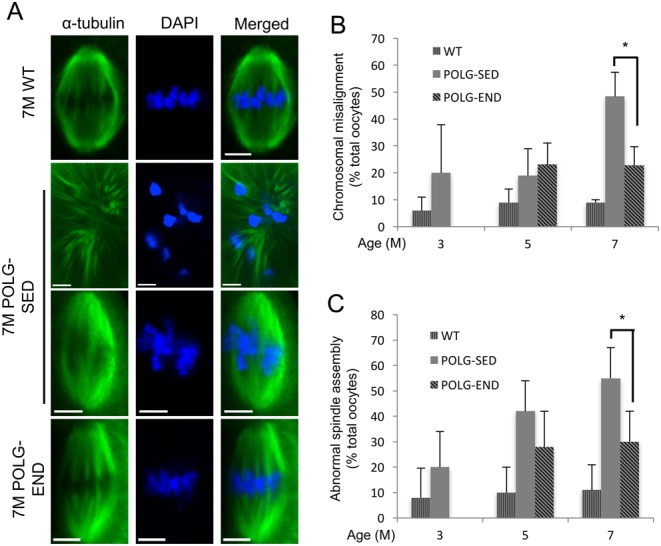
Exercise improves meiotic spindles and chromosome alignment in POLG mice at 7 months of age. (A) Representative laser scanning confocal micrographs of meiotic spindles in MII oocytes from 7-month-old (7 M) WT, POLG-sedentary (POLG-SED) and POLG endurance-exercised (POLG-END) mice; α-tubulin labeling of spindle (green) and DNA labeled with DAPI (blue). Scale bars = 5 μm. (B and C) Occurrence of spindle abnormalities and chromosome misalignment in oocytes from 3 M WT and POLG-SED, and 5 and 7 M WT, POLG-SED and POLG-END mice (mean shown, error calculated as s.d. of a binomial distribution; n = 20–39 oocytes from 5–6 mice per group; *P < 0.05).